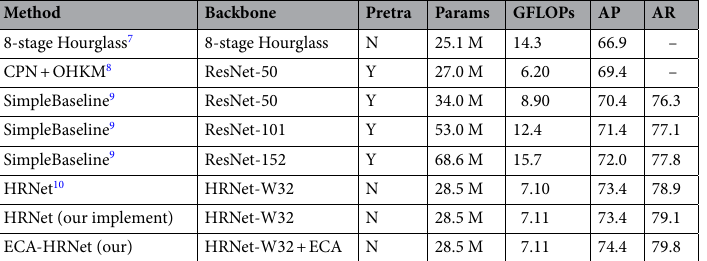
Table 3. Comparison on the COCO2017 validation set (Pretra = backbone pretrained on the ImageNet classification task; OHKM = online hard keypoint mining 8 ).